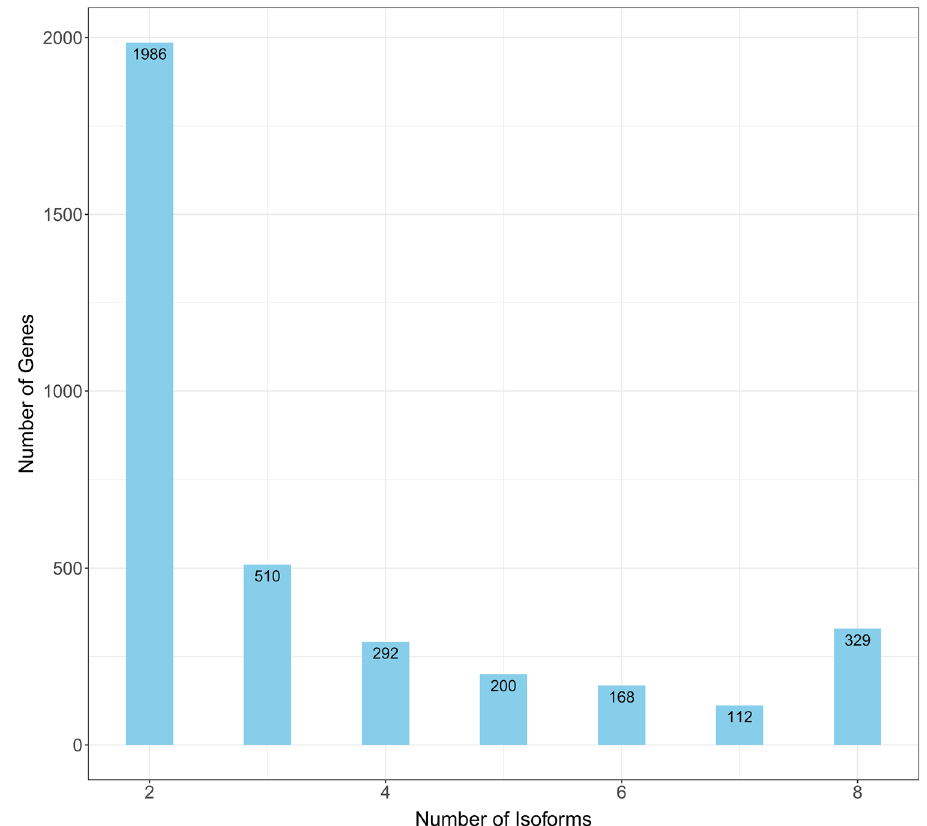
Figure 1. Number of isoforms identified for unigenes in faba